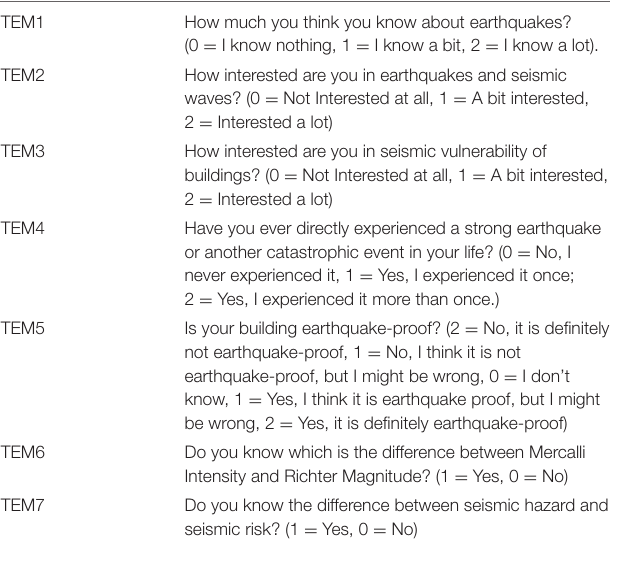
TABLE 4 | Questions used to measure self-reported knowledge.